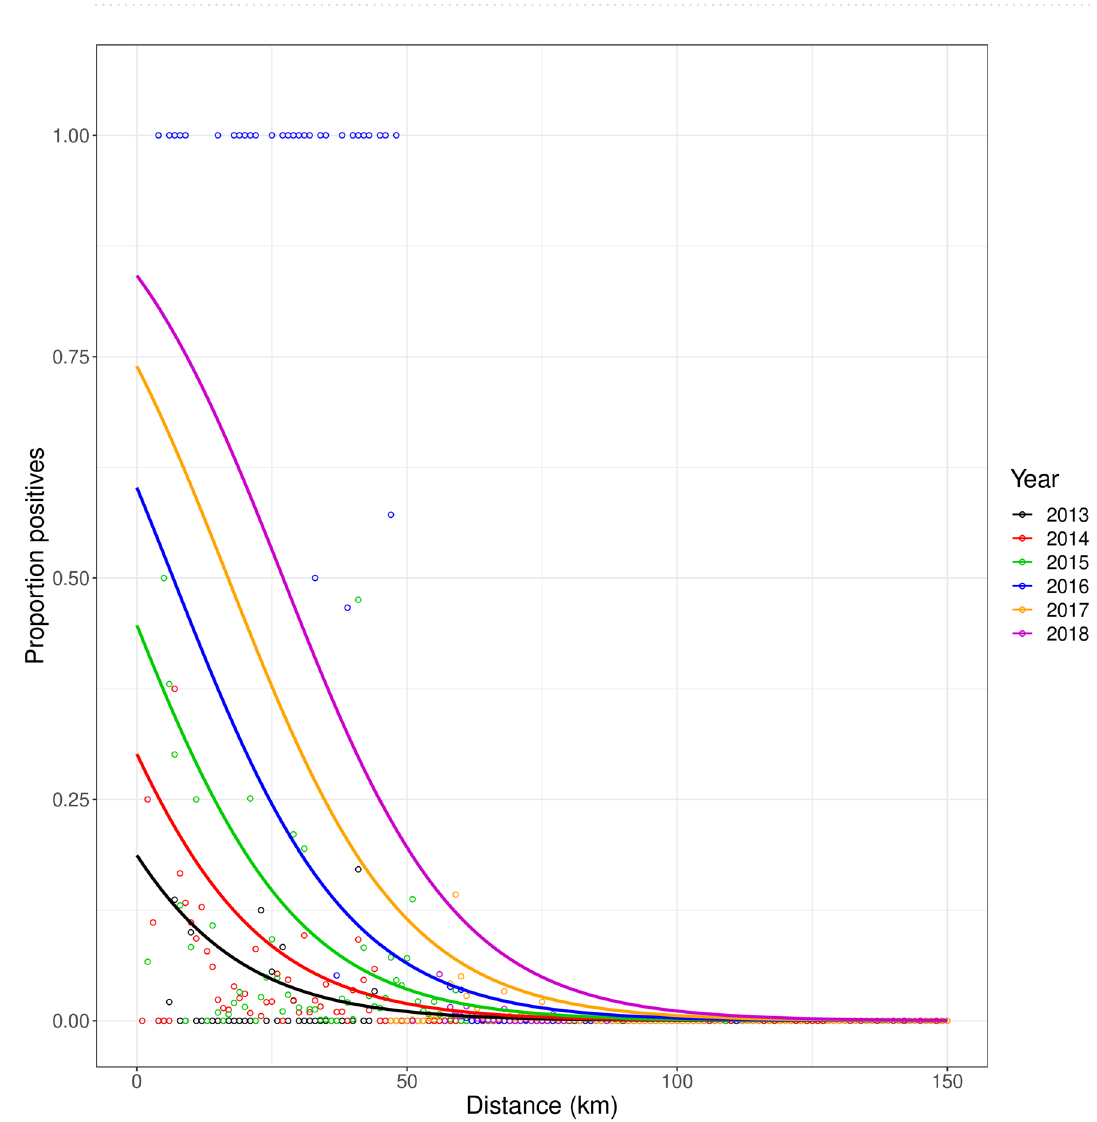
Figure 6. Modelled advance of the logistic front of X. fastidiosa at a yearly time step, 2013–2018. The disease front was fitted on all data using a logistic model containing a parameter for the rate of range expansion c and assuming a beta-binomial error distribution (Eq.